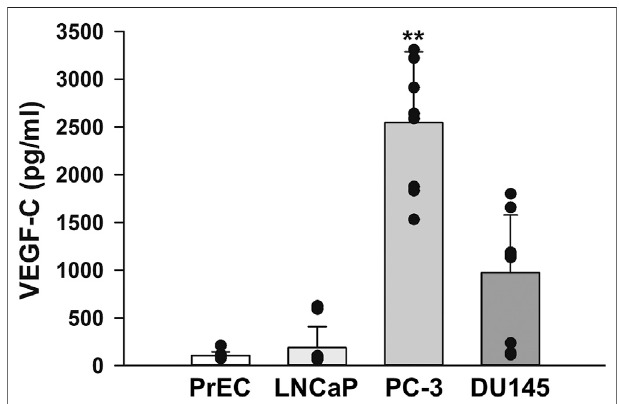
FIGURE 5 | VEGF-C levels in human prostate cancer cells. The levels of VEGF-C in the culture media of human prostate epithelial PrEC cells and prostate cancer LNCaP, PC-3, and DU145 cells were measured using the humanVEGF-CQuantikineELISAkit.NotethatlargeramountsofVEGF- C were secreted from PC-3 cells than from PrEC, LNCaP, and DU145 cells ( n (cid:1) 10). Data are presented as means ± S.D. ** p < 0.01 vs. PrEC, LNCaP, or DU145 cells (Scheffé ’ s test following